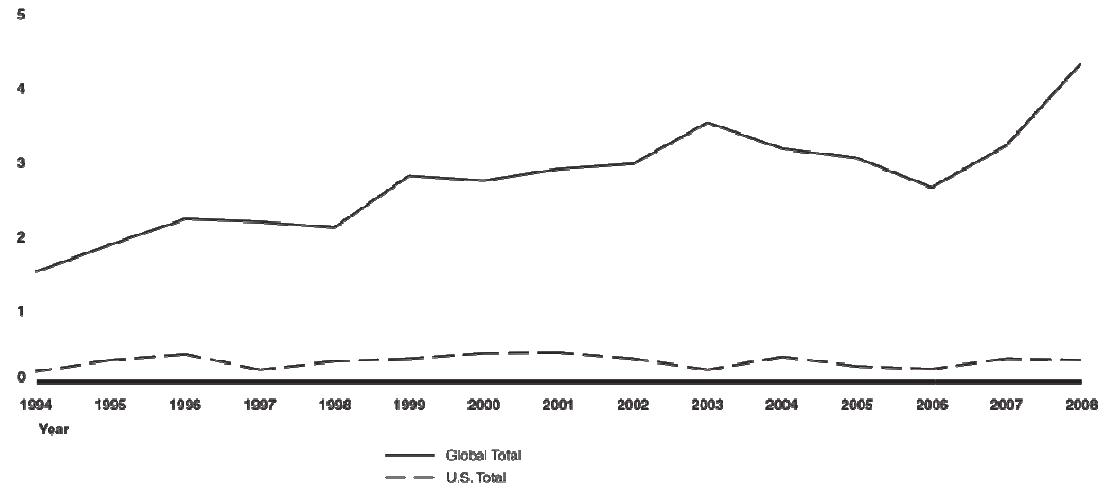
Figure 1. Value of US and Global Exports of Nuclear Reactors, Major Components and Equipment, and Minor Reactor Parts, 1994 through 2008, in 2010 US